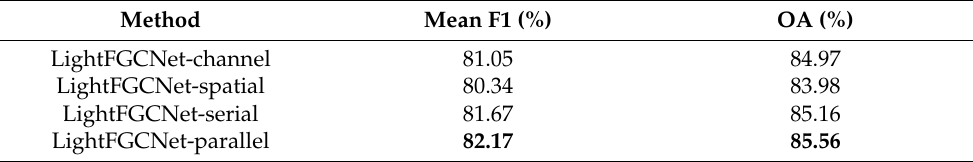
Table 1. The ablation study of the attention module. The bold indicates the best